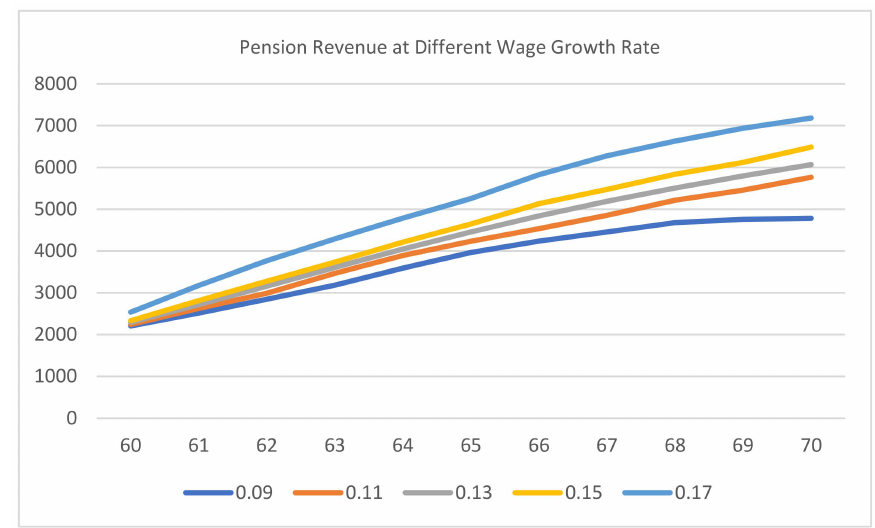
Figure 4. Pension revenue at different wage growth rates under plan I.